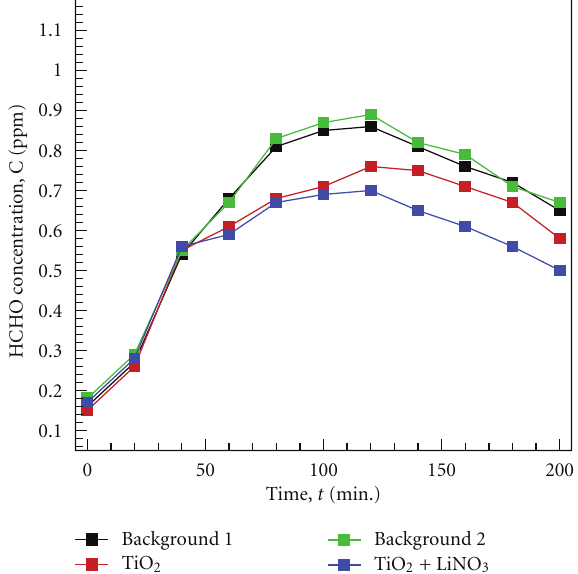
Figure 11: The degradation performance for gaseous formaldehyde under irradiation of UVA lamps at 22 ◦ C.